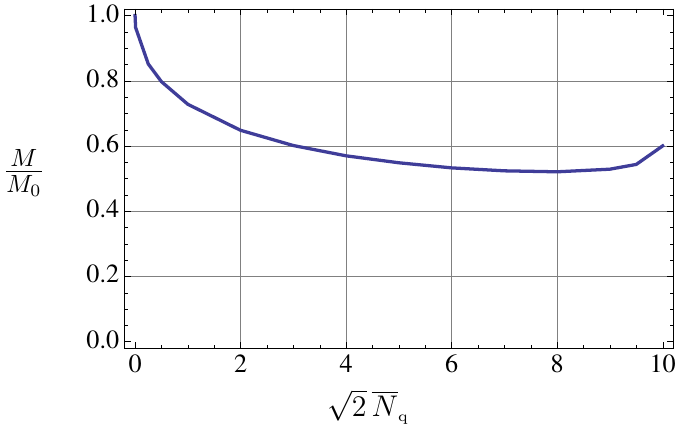
Figure 19. Mass of a string stretching from the origin of a zero-temperature solution to the position of the LP as a function of the charge density, normalized to the value at N